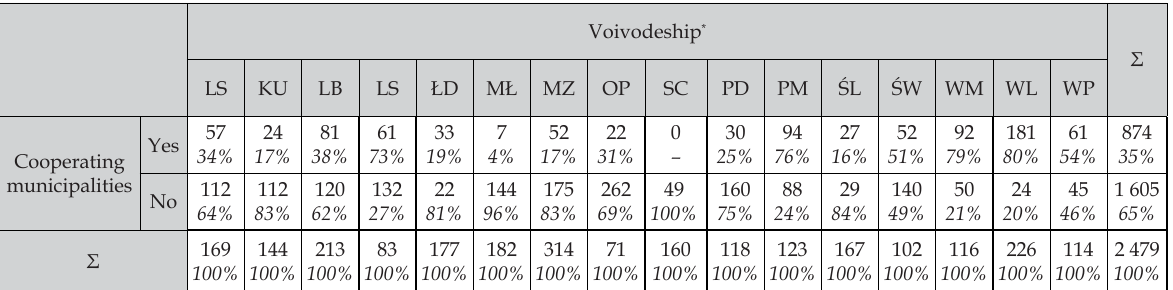
Table 1. Inter-municipal cooperation in waste management, by voivodeship.